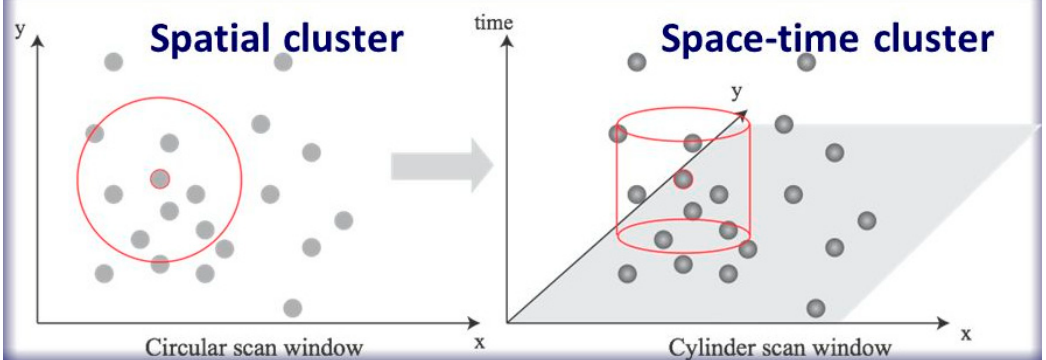
Figure 3. Space and space–time scan window for detecting clusters (sources: Kulldorff [42], Kulldorff, et al. [44]).